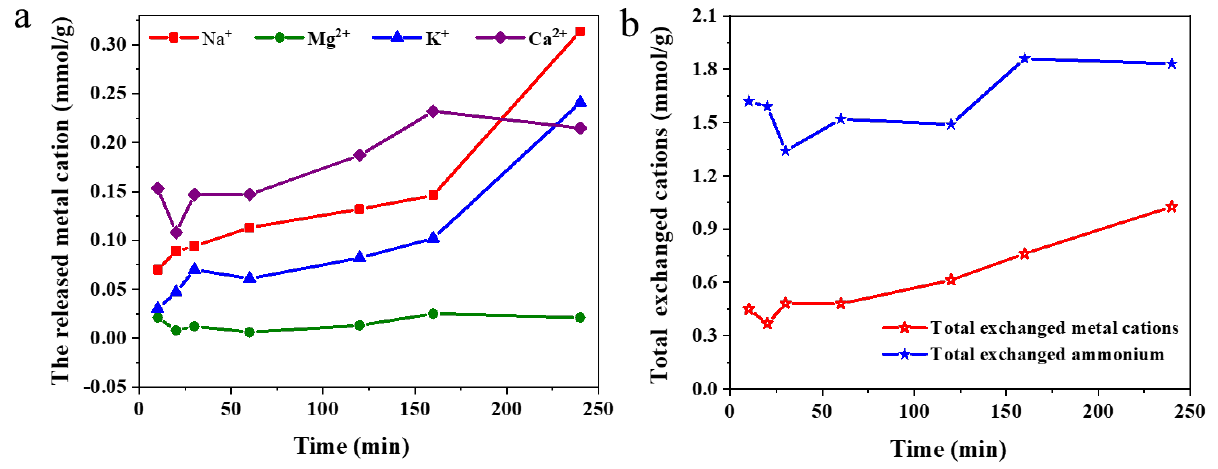
Figure 3. The exchange of the metal cations in natural zeolite with ammonium in solution. ( a ) Released metal cations contents; ( b ) Comparison of total exchanged ammonium and metal cations contents.